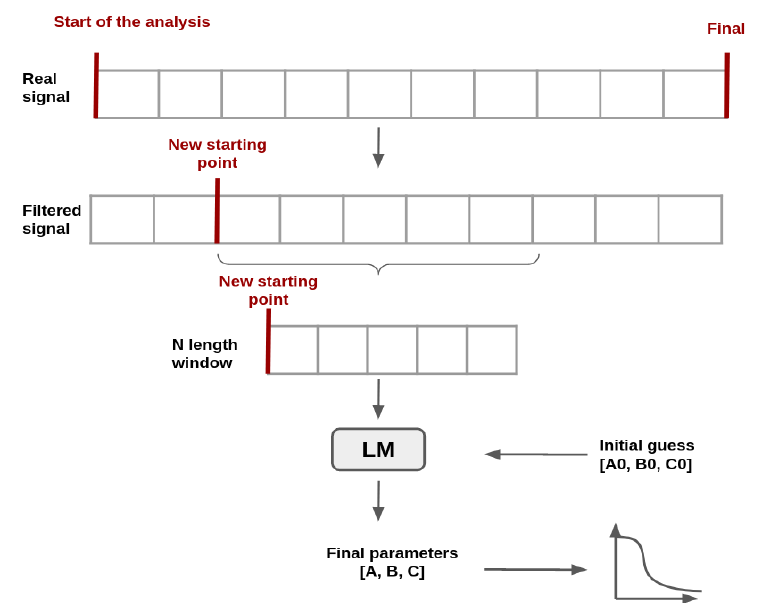
Figure 9. Diagram of the pipeline